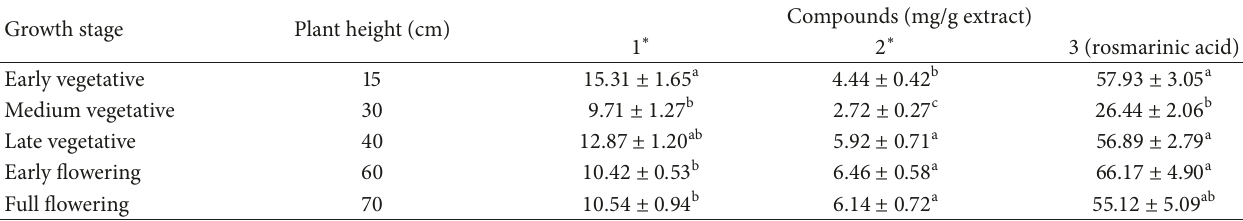
Table 2: Individual phenolic compounds in the perilla extracts at different growth stages.